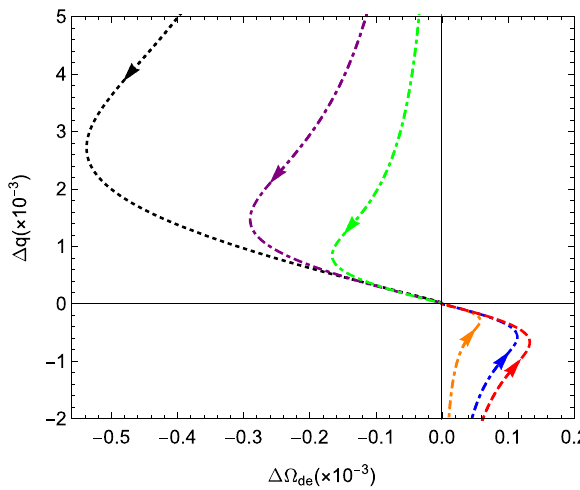
Fig. 7 The dynamic attractor solution in the generalized Rastall grav- ity. The results show the deviations from the specific solution governed byaspecificchoiceofinitialconditions.Thecalculationsarecarriedout for the differences in the density parameter of dark energy (cid:13) de ( x -axis) and those in deceleration parameter q ( y -axis). Each individual curve is obtained by evaluating the cosmic evolution with an arbitrary initial condition. The red dashed curve and black dotted curve correspond to the same perturbations investigated in Figs. 1 and 4. The calculations are carried out for generalized Rastall gravity by using the parameters given in the text